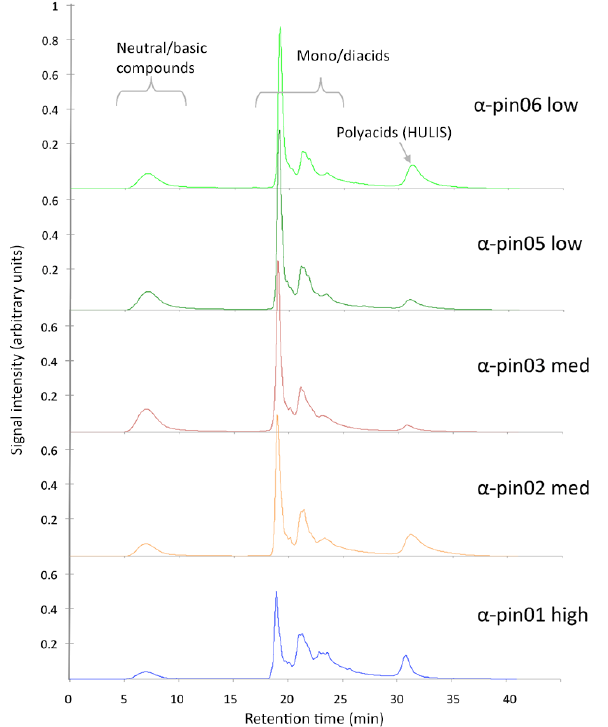
Figure 4. HPLC chromatograms of α -pinene SOA water ex- tracts. Chromatographic features are grouped into neutral, mono- /dicarboxylic acid, and polycarboxylic acid classes based on their affinity for the column phase. Sample identifications are provided in Table 1.